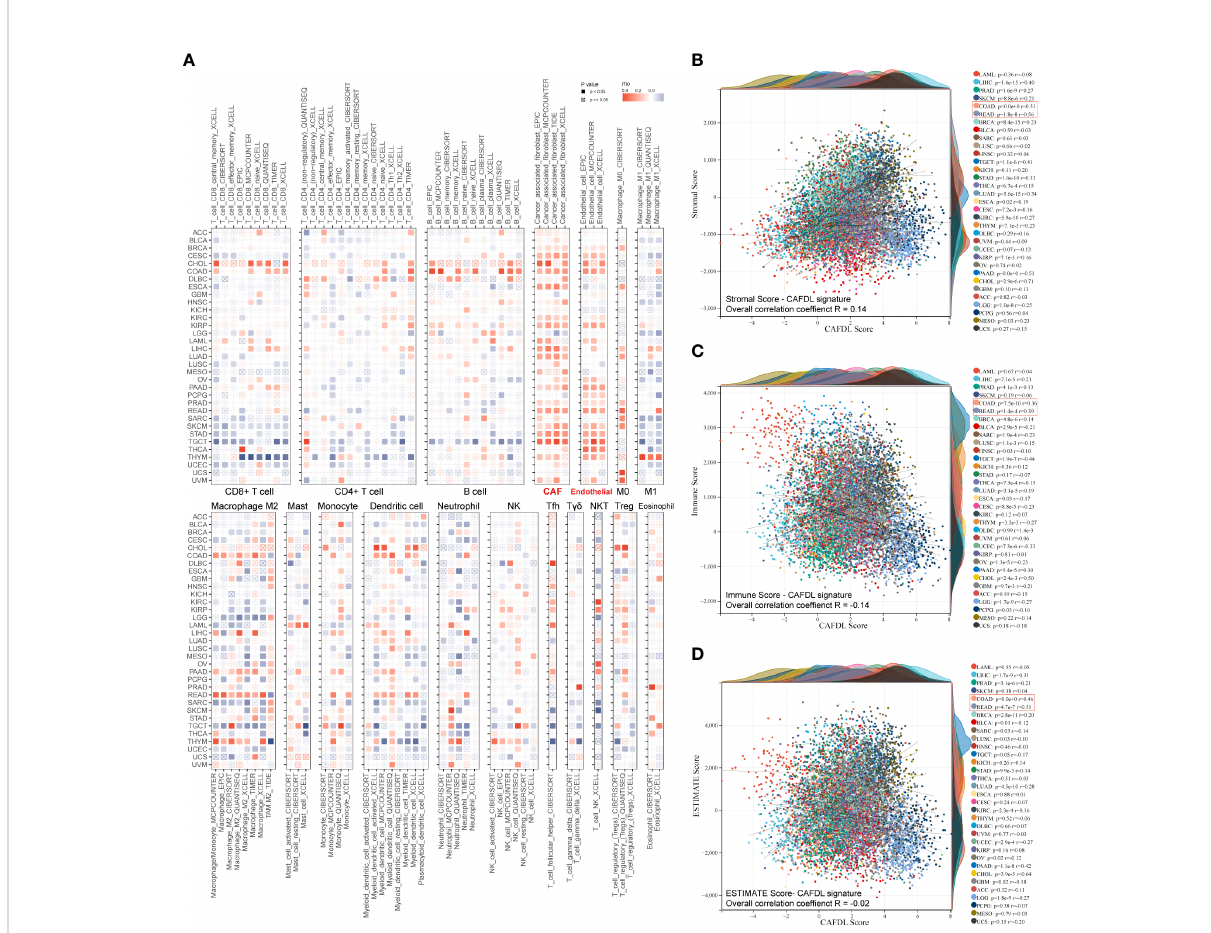
FIGURE 6 Pan-cancer immune correlates of CAFDL signature. (A) Correlation of CAFDL signature with immune cell in fi ltration evaluated using seven algorithms: TIMER, EPIC, xCELL, CIBERSORT, QUANTISEQ, MCPcounter, and TIDE across pan-cancer. (B – D) Correlation of CAFDL signature with stromal score (B) , immune score (C) , and ESTIMATE score (D) across